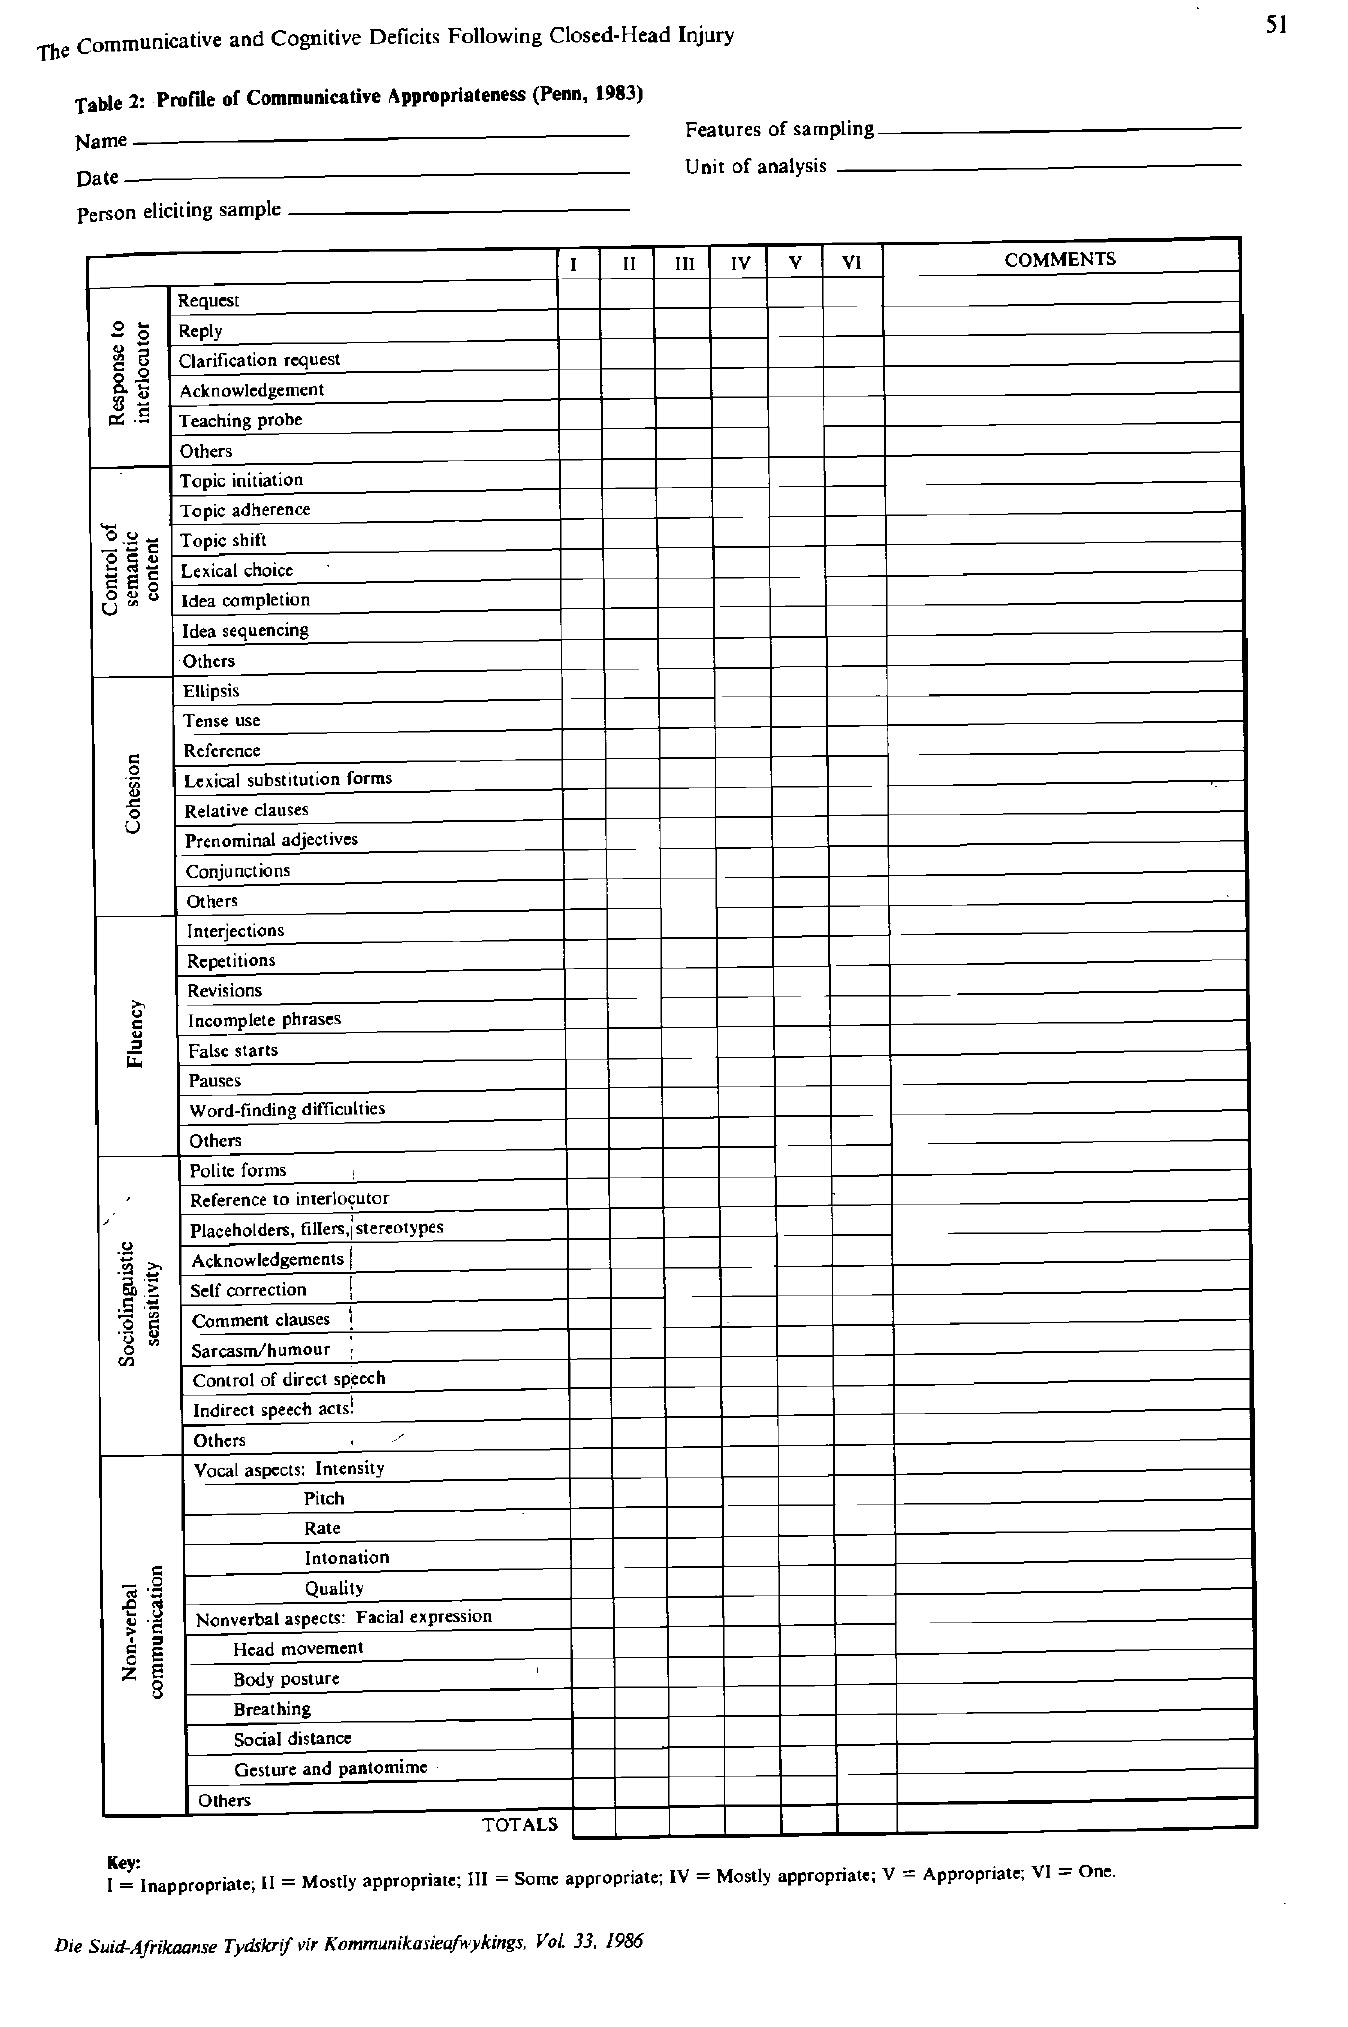
Features of sampling.